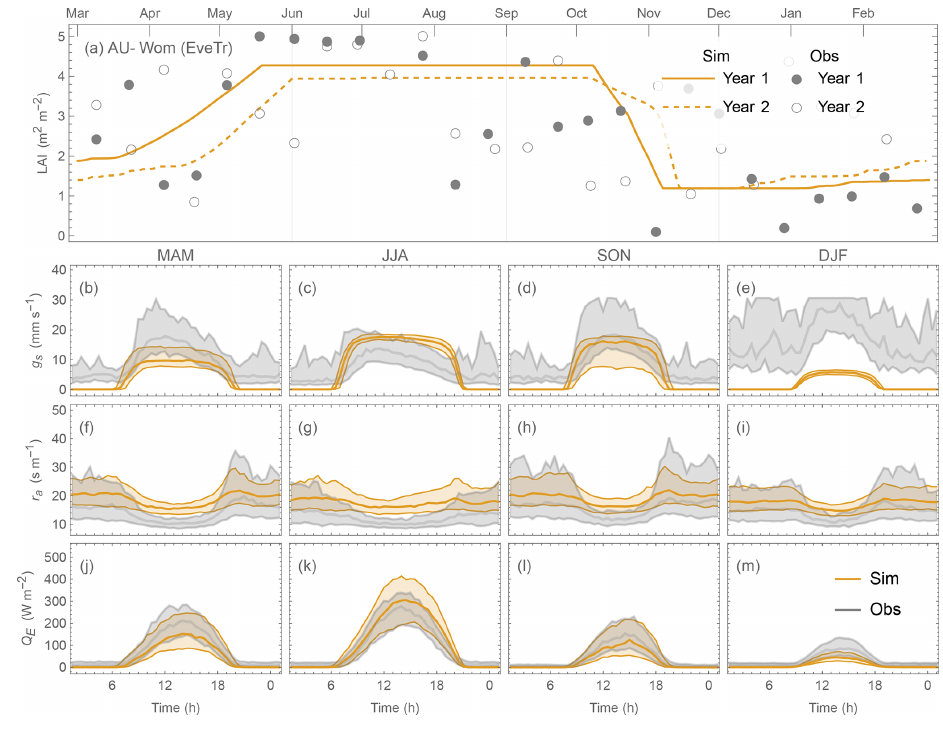
Figure 20. As Fig. 19, but for AU-Wom (EveTr, PS = 0.18).